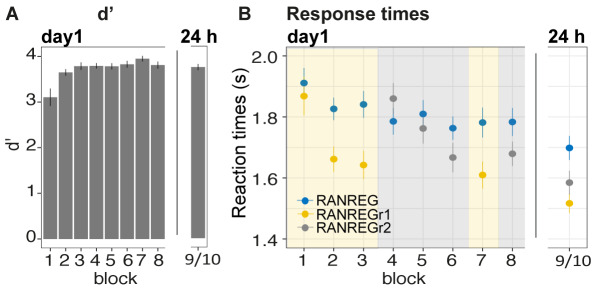
Experiment 3 (N = 29): memories of a set of reoccurring regularities are not overwritten by subsequent memorization of another set.Participants were exposed to a set of three reoccurring patterns in the first three blocks (REGr1, yellow shading), followed by three blocks in which another set of patterns was reoccurring (REGr2, grey shading). The final blocks (7 and 8) tested memory for set 1 and 2, respectively. After 24 hr, memory for the two sets was tested again. (A) d’ across all blocks on day 1 and after 24 hr. Error bars indicate 1 s.e.m. (B) RT to the transition from random to regular pattern across blocks for RANREG, RANREGr1 and RANREGr2 on day 1 and after 24 hr.﻿ Error bars indicate 1 s.e.m. Figure 6—figure supplement 1A plots the RT advantage for each intra-block presentation. Figure 6—figure supplement 1B shows the RT data with N = 19.